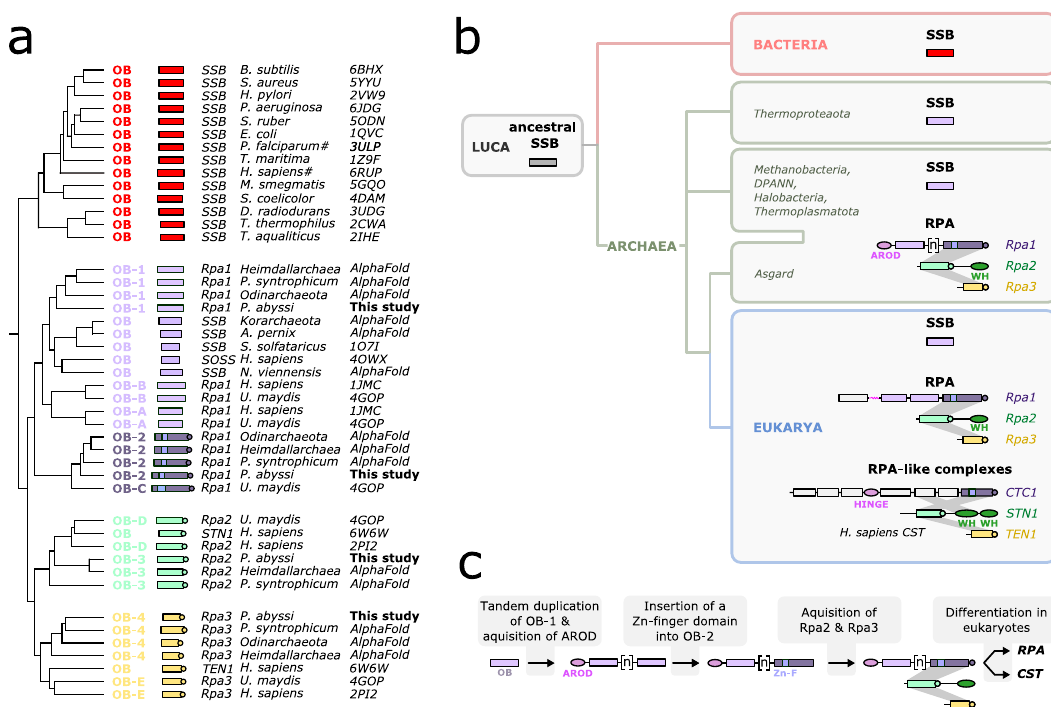
Fig. 6 | Evolutionary implications for the RPA evolution in Archaea and Eukarya. a Structure-based dendrogram produced by DALI, based on average linkage clustering of the Z-scores of the structural similarity matrix. The available structures weresupplemented withAlphaFoldmodels 60 ofadditionalcrenarchaeal and thaumarchaeal SSBs and trimeric RPAs from Asgard archaea, the postulated